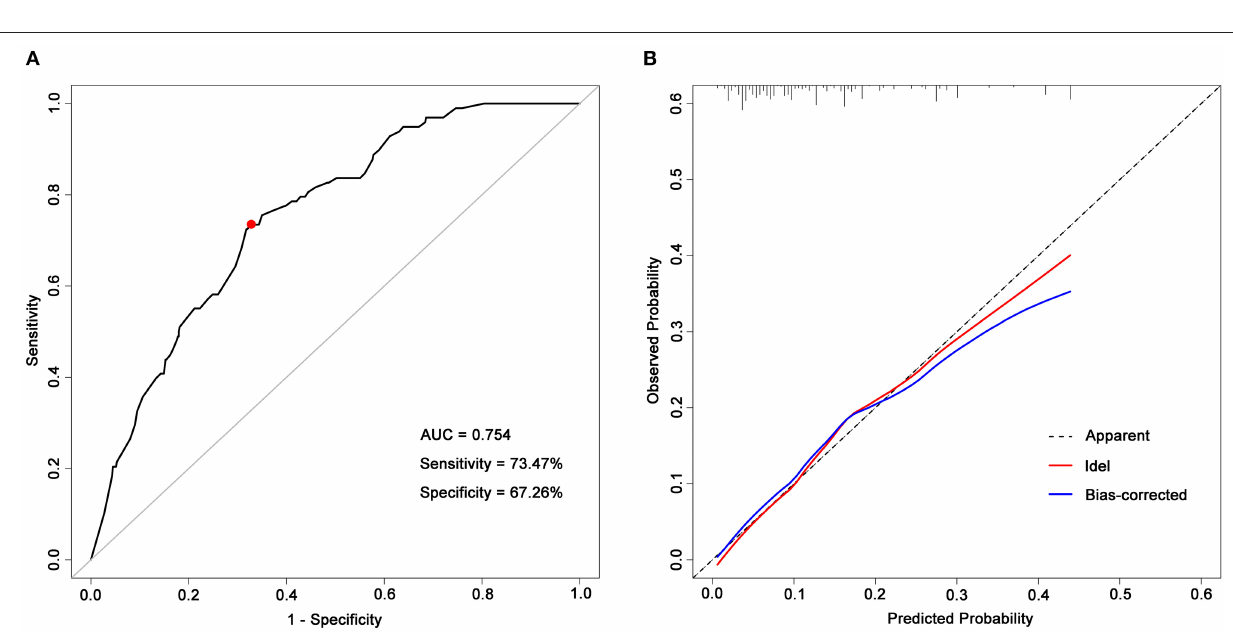
FIGURE 2 | ROC curve and a calibration curve of the prognostic model. (A) ROC curve of the prognostic model. The prognostic model had acceptable discriminative power with an AUC of 0.754 (95% CI, 0.707–0.800). The red dot represents the optimal cutoff value, corresponding to the sensitivity and specificity of 73.47 and 67.26%, respectively; (B) Calibration curves of predicted probability of a 5-year unfavorable global functional outcome ( x -axis) vs. observed probability ( y -axis). The Hosmer–Lemeshow goodness-of-fit test was used to compare predicted probability and observed probability, p-value > 0.05 indicates good calibration. AUC, areas under receiver operating characteristic